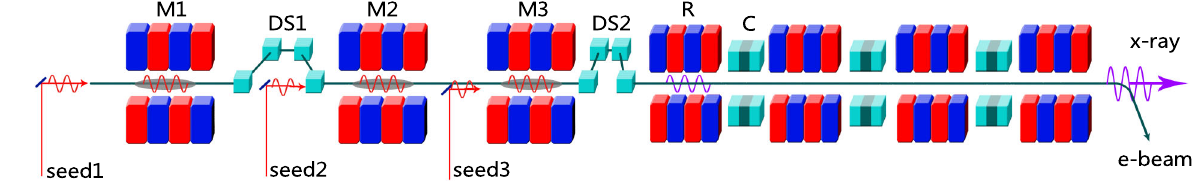
FIG. 1. Schematic of the proposed scheme for generation of attosecond x-ray pulse trains. (M: modulator; DS: dispersive section; R: radiator; C: